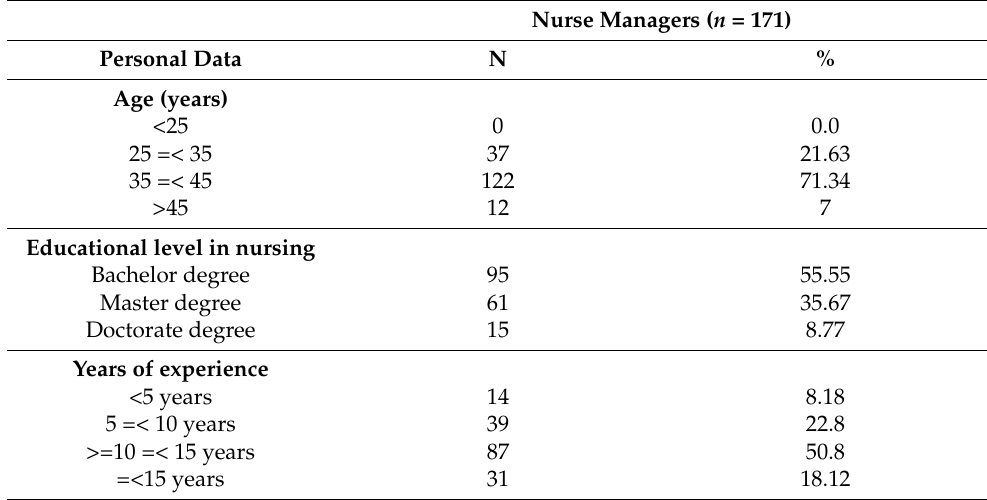
Table 2. Personal data of studied nurse managers ( n = 171).